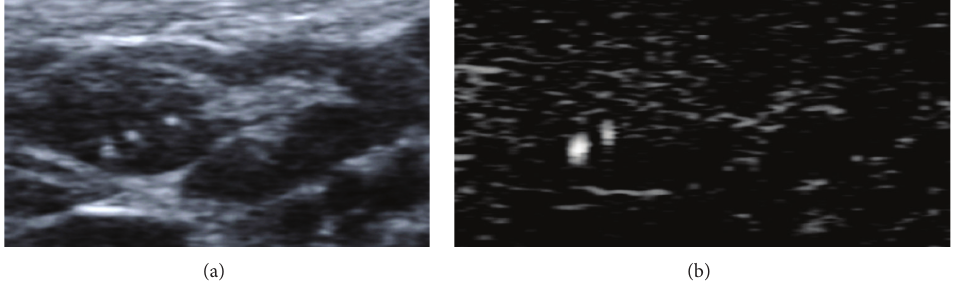
Figure 4: Focal metastasis in upper pole of lymph node at B-mode and BFI examination in patients with papillary thyroid cancer. The lymph node presents BFI-TS in the metastatic